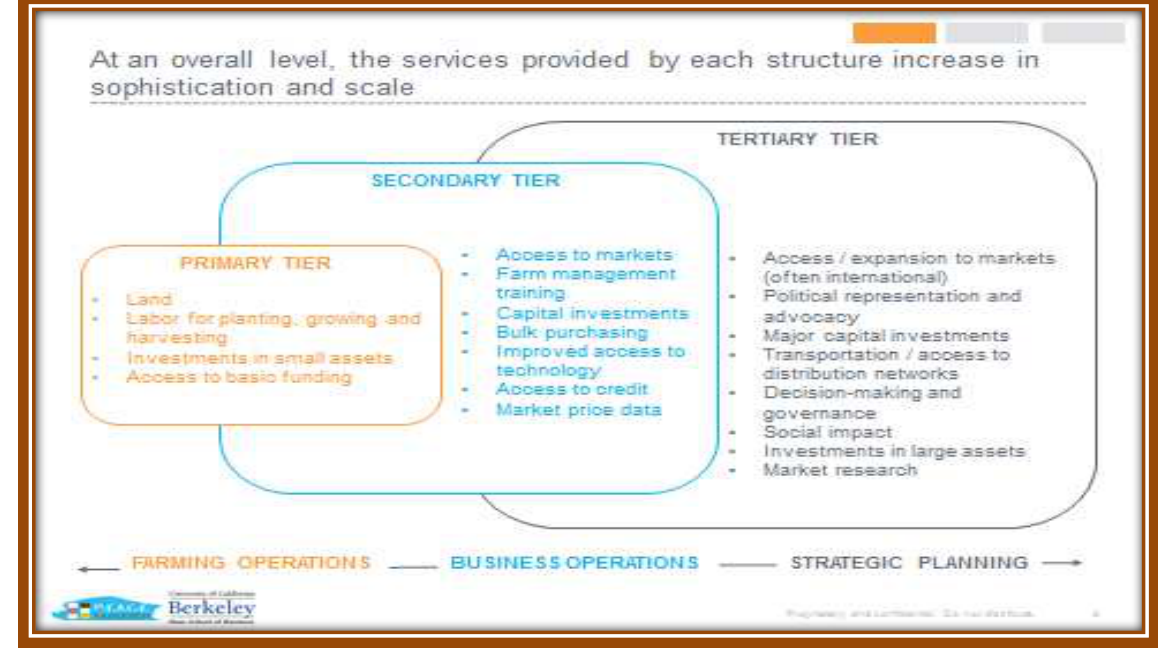
Fig. 1. Three tiers of cooperatives